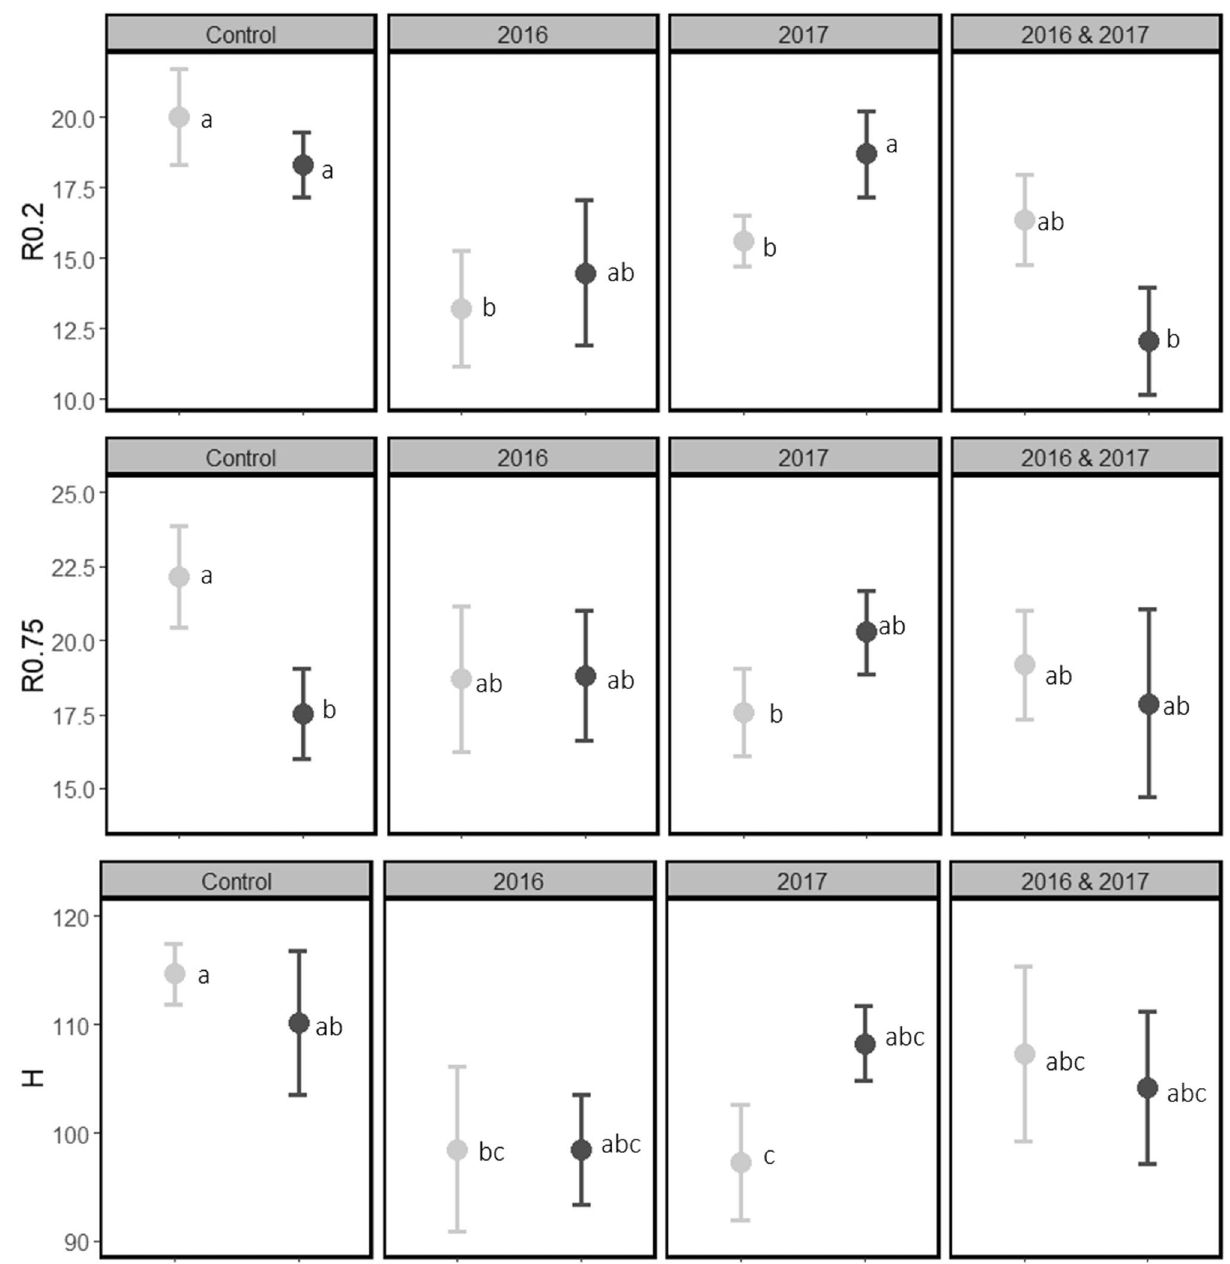
Figure 2. Total growth increment of pines trees in 2017 (mean ± SEM) at 0.2 m stem height (R0.2), 0.75 m stem height (R0.75) and in height (H). Vertical panels represent the browsing treatments: control (un-clipped), clipped 2016, clipped 2017 and clipped 2016 and 2017. Colours represent the sawfly treatments: sawflies once (light grey markers and error bars) or sawflies twice (dark grey markers and error bars). Letters denote significant differences between individual treatments. Mean growth (left to right, top to bottom): 20.02, 18.31, 13.21, 14.47, 15.63, 18.69, 13.36 and 12.06, 22.15, 17.51, 18.69, 18.83, 17.57, 20.27, 19.17, 17.88 mm and, 114.7, 110.1, 98.5, 98.4, 97.3, 108.2, 107.3, 104.1